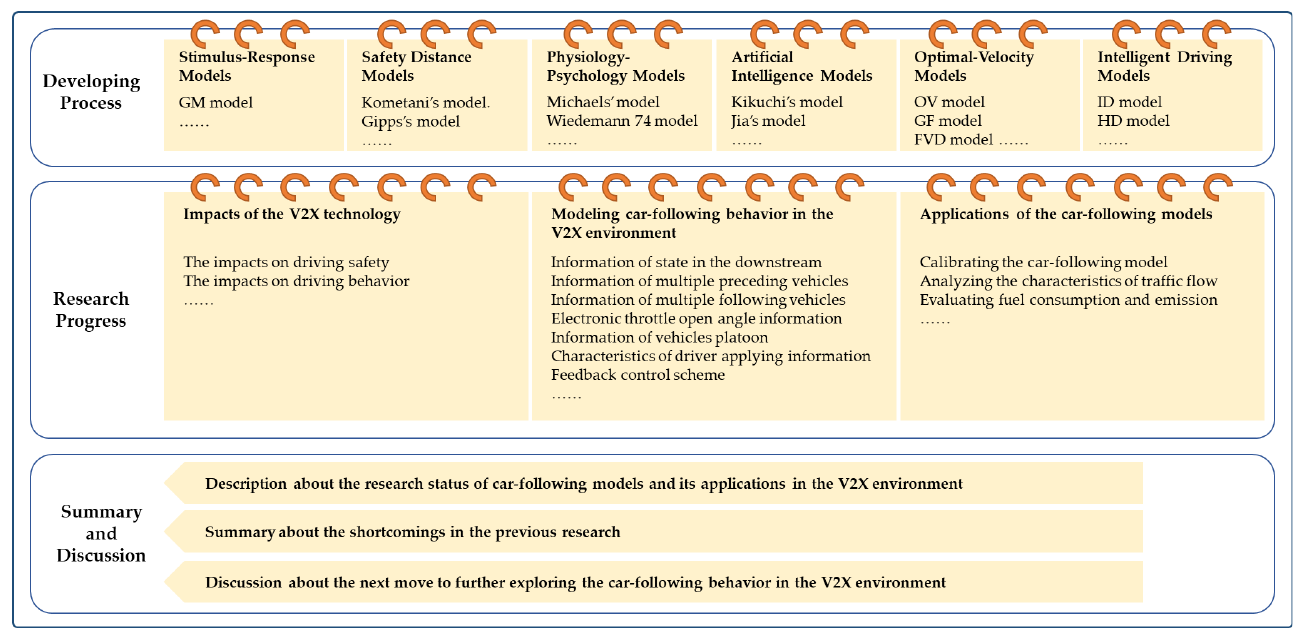
Figure 1. Framework of the review